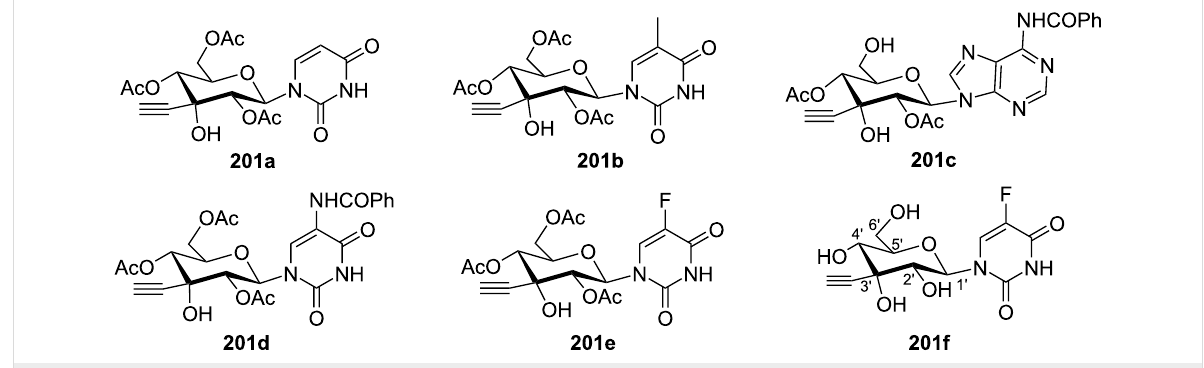
Figure 2: 3 ′ - C -Ethynyl- β - ᴅ -allopyranonucleoside derivatives 201a–f .